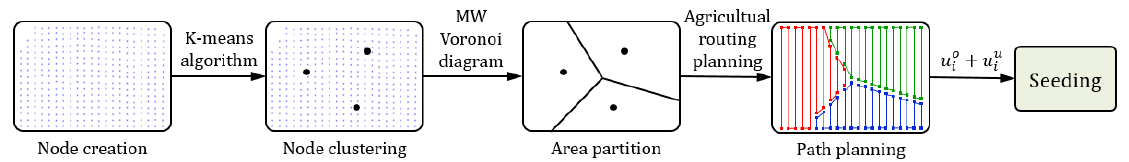
Figure 1. Global system flowchart of multi-robot task allocation (MRTA) for heterogeneous seeding robots.